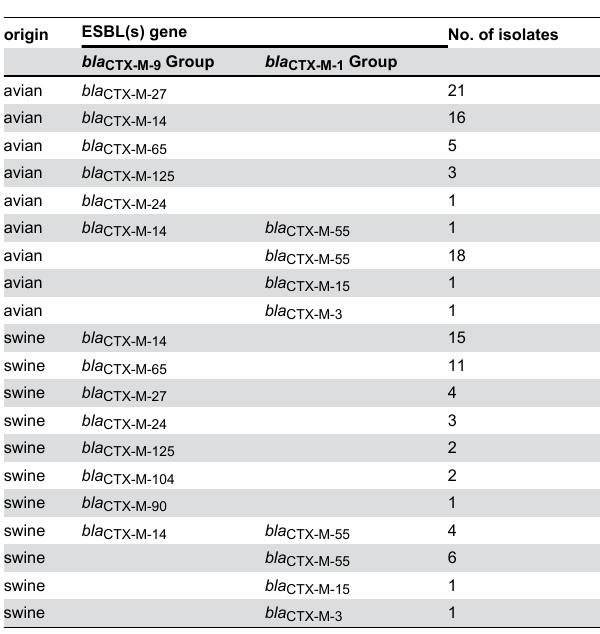
Table 2. Distribution of CTX-M subgroups and alleles amongst Escherichia coli isolates from different animal